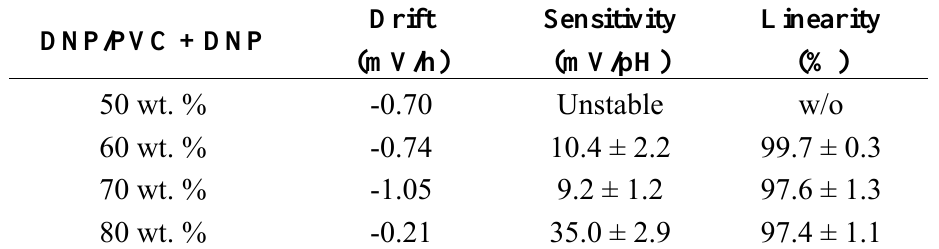
Table 2. Performance of REFETs with PVC membranes with different contents of